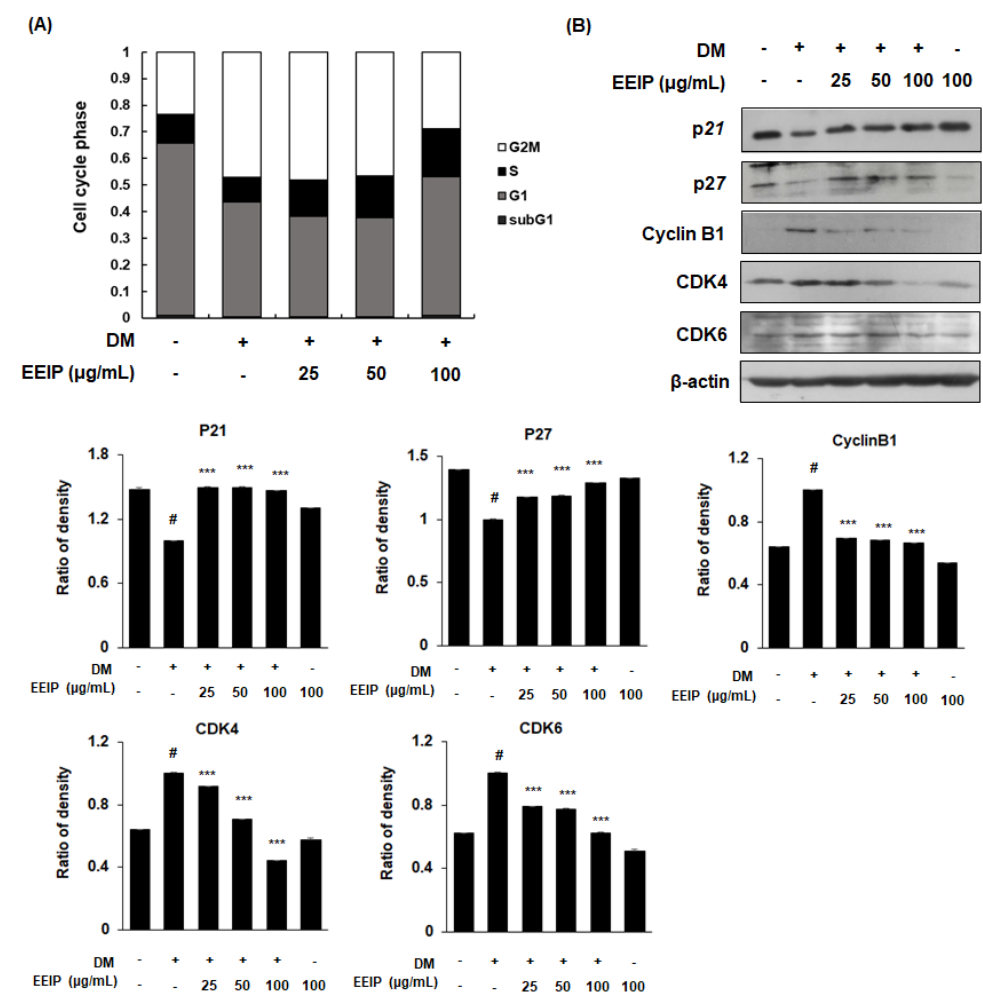
Figure 3. Regulation of mitotic clonal expansion (MCE) in EEIP-treated 3T3-L1 preadipocytes. Cells were differentiated into adipocytes in differentiation media (DM), with or without EEIP (25, 50, or 100 μg/mL), for 24 h. ( A ) Cell cycle progression was analyzed by flow cytometry in EEIP-treated 3T3-L1 preadipocytes. ( B ) Protein levels of cell cycle regulatory proteins were determined by West- ern blotting analysis. β-actin was used as the internal control. Densitometric analysis was performed using Bio-Rad Quantity One Software (BioRad; Hercules, California, USA). Values are represented as the mean ± SD, # p < 0.05 vs. the GM group, *** p < 0.001 vs. the DM group. 3.4. EEIP Relieves Body Weight and Fat Tissue in HFD-Fed Obese Mice To confirm the reducing effect of EEIP on lipid accumulation in vivo, we determined the lowering effect of EEIP, orlistat as a positive control, or vehicle on the body and fat tissue weight in HFD-fed obese mice for 15 weeks. As shown in Figure 4A, the HFD group showed a significant increase in body weight compared to the control group from 5 weeks. In contrast, EEIP pre- and post-administration groups began to show significant body weight gain loss from 7 and 13 weeks, respectively. At the end of the experiment, the body weight of the HFD group was markedly increased compared to that of the control group (27.08 ± 0.24 g at the control group vs. 38.40 ± 0.26 g at the HFD group, p < 0.05), and EEIP pre- or post-administration significantly reduced the HFD-increased body weight (38.40 ± 0.26 g at the HFD group vs. 32.56 ± 0.50 g at the EEIP pre-administration 100 mg/kg group, p < 0.001; 33.27 ± 0.30 g at the EEIP pre-administration 300 mg/kg group, p < 0.001; 34.81 ± 0.45 g at the EEIP post-administration 100 mg/kg group, p < 0.01; 33.49 ± 0.45 g at the EEIP post-administration 300 mg/kg group, p < 0.01), similar to that observed in the orlistat group (32.24 ± 0.28 g at 20 mg/kg, p < 0.001) (Figure 4B). DXA analysis revealed that fat accumulation and fat in the tissue (%) of the HFD group were significantly in- creased compared with the control group (15.80 ± 0.92% at the control group vs. 40.02 ±